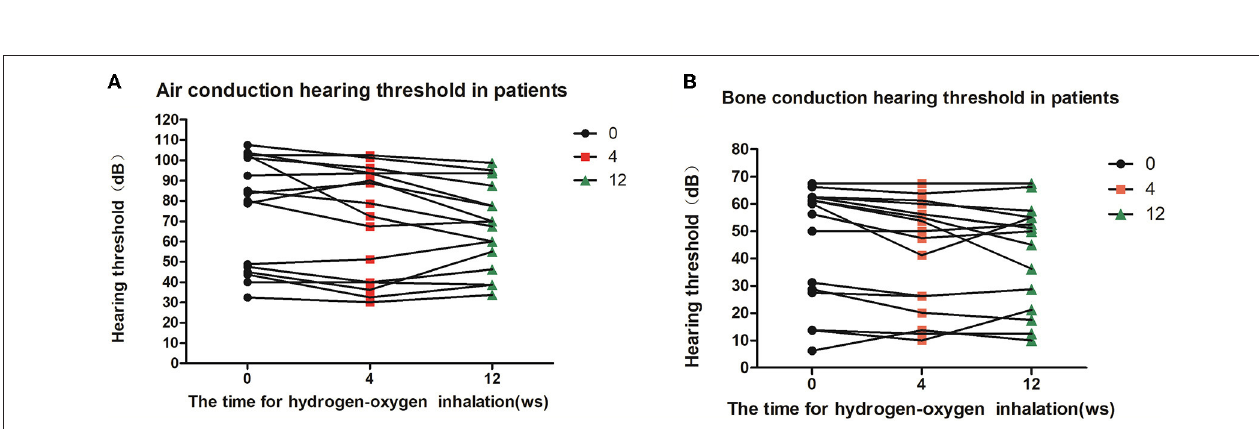
FIGURE 3 | Patients’ hearing changes at different time points of hydrogen-oxygen inhalation. (A) Diagram of changes of air conduction hearing threshold at different time point after hydrogen-oxygen gas inhalation; (B) Diagram of changes of bone conduction hearing threshold at different time point after hydrogen-oxygen gas inhalation. One-way analysis of variance was used for data